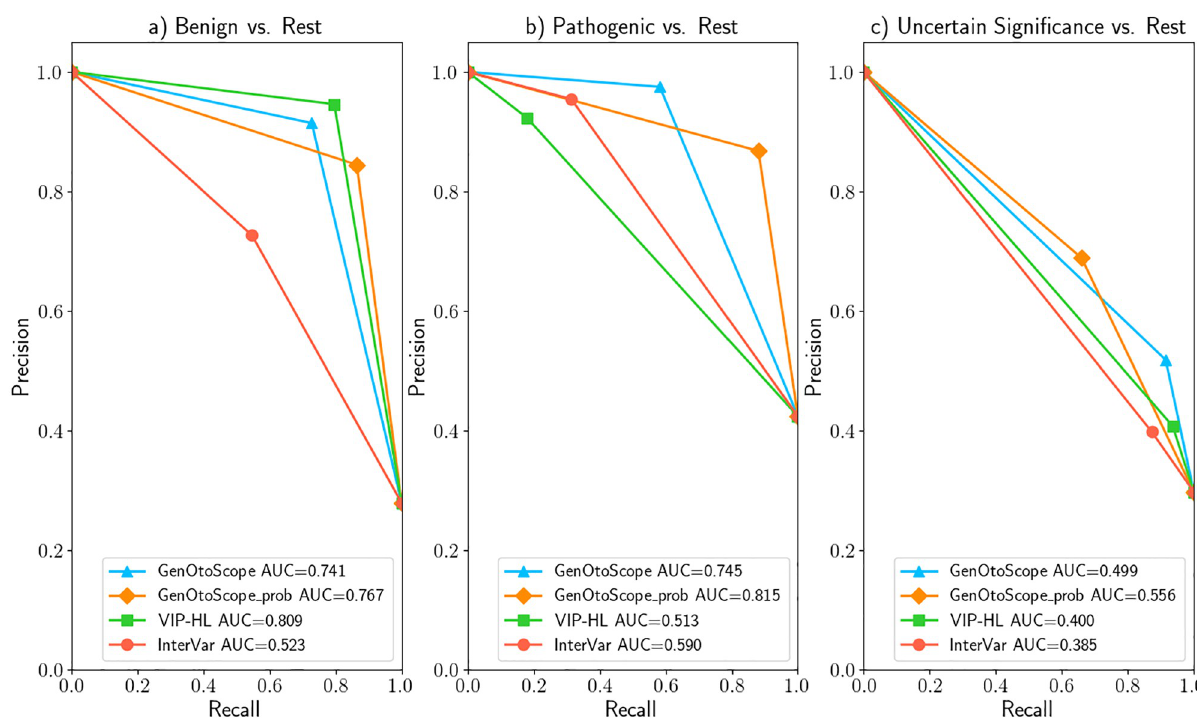
Fig 8. Precision-recall curves and AUC scores of all classification tools for VCEP-HL data set. (A) Prediction of “Benign” broader class versus “Pathogenic” broader class and “VUS” class (B) Prediction of “Pathogenic” broader class versus “Benign” broader class and “VUS” class (C) Prediction of “VUS” class versus “Benign” broader class and “Pathogenic” broader class.